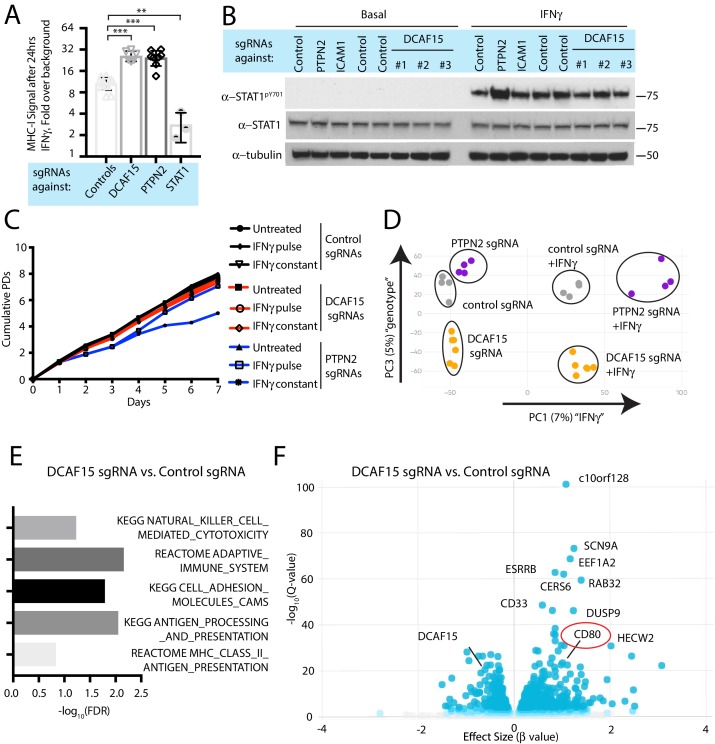
DCAF15 disruption leads to an inflamed state distinct from dysregulated IFNγ-JAK-STAT signaling.(A) Flow cytometry measurement of cell surface MHC-I expression in K562 cells transduced with the indicated sgRNAs after 24 hr of 10 ng/ml IFNγ treatment. ***p<0.0001; **p=0.0044, Mann-Whitney test. (B) Western blots illustrating total and phosphorylated STAT1 after 30 min of 1 ng/ml IFNγ treatment in K562 cells infected with the indicated sgRNAs. (C) Growth rate of K562 cells expressing the indicated sgRNAs, cultured under basal conditions (‘untreated’), treated 24 hr with 10 ng/ml IFNγ (‘IFNγ pulse’), or continuously retreated with 10 ng/ml IFNγ every day (‘IFNγ constant’). (D) Principle component analysis (for principle components (PC) 1 and 3) of transcriptomes from K562 cells expressing the indicated sgRNAs and treated + /- 10 ng/ml IFNγ for 24 hr. (E) Selected GO terms, identified by RNA-seq, enriched in DCAF15 KO cells. Negative log10 transformation of the Benjamini-Hochberg corrected P value. (F) Volcano plot of genes differentially expressed between DCAF15 KO cells compared to control KO cells. Selected genes are highlighted. The FDR-corrected P-value generated from a likelihood ratio test (Q-value) is plotted against an approximate measure of the fold change in expression (Beta value).